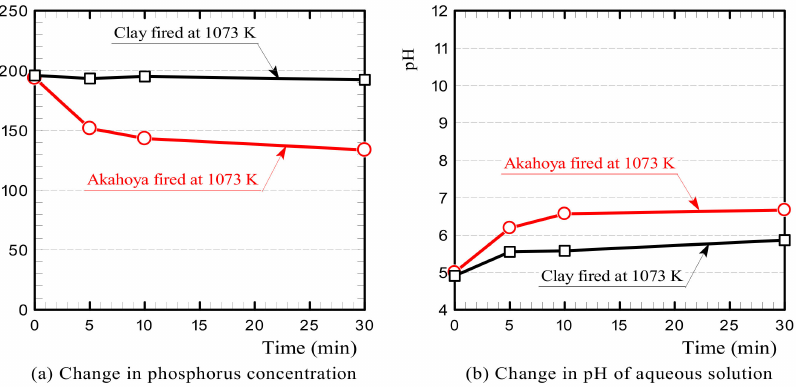
Figure 16. Changes in the ( a ) phosphorus concentration and ( b ) pH of the solution containing the Akahoya or clay